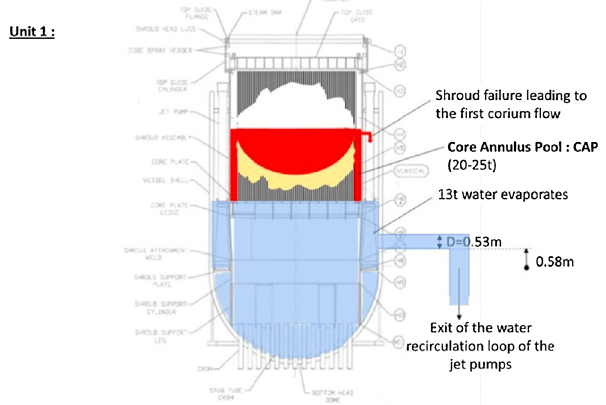
Fig. 4. Illustration of the shroud failure from the core annulus pool: ∼ 6 h 40 after the reactor